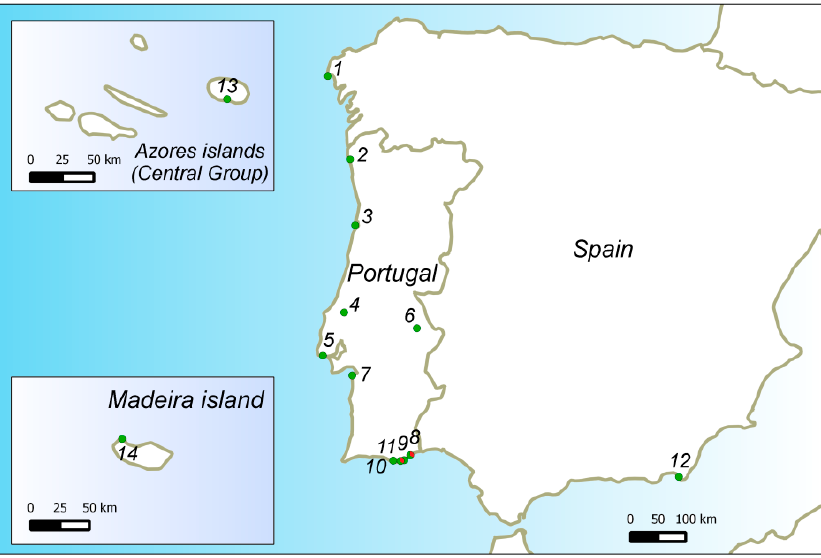
Figure 1. Map of sampling locations: 1—Finisterra (“FIN”); 2—Viana do Castelo (“VCA”); 3—Aveiro (“AVE”); 4—Rio Maior (“RIO”); 5—Oeiras (“OEI”); 6—Vaiamonte (“VMT”); 7—Comporta (“CMP”); 8—Tavira (“TAV”); 9—Fuseta (“FUS”); 10—Ludo (“ML”); 11—Quinta de Marim (“PM”);12—Cabo da Gata, Almeria (“ALM”); 13—Terceira, Azores Island (“AZO”); 14—Porto Moniz, Madeira Island (“MAD”). B. vulgaris subsp. maritima is represented by green color; B. macrocarpa is represented by red